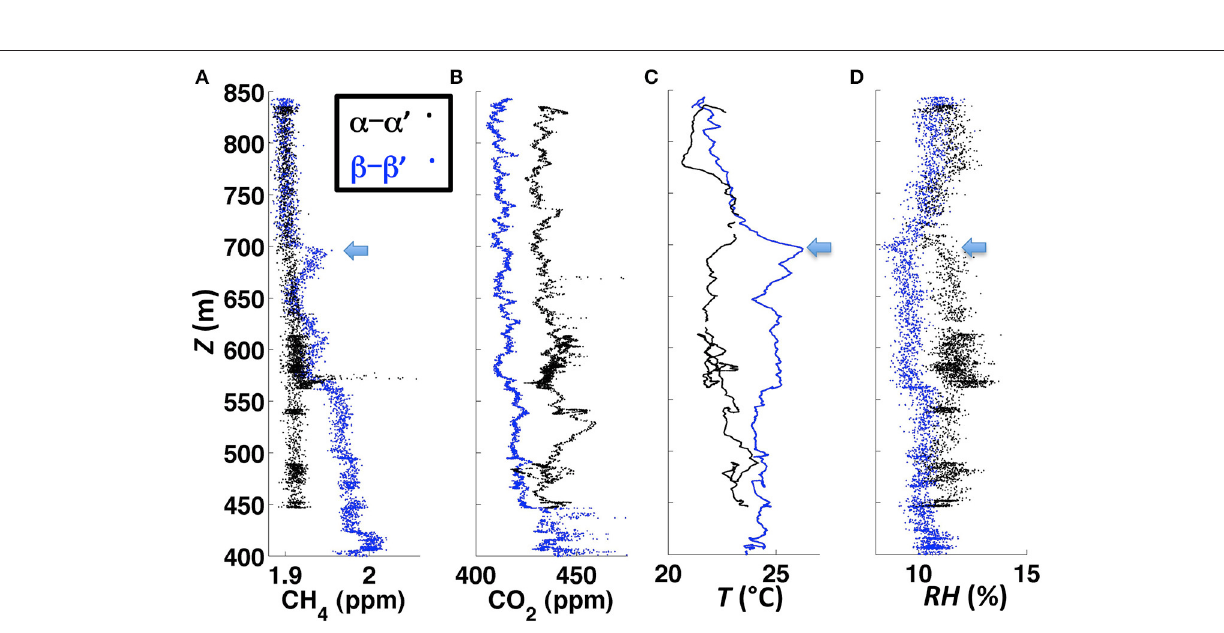
FIGURE 4 | AMOG altitude ( z ) profile data into the San Bernardino Mountains for (A) methane (CH 4 ), (B) carbon dioxide (CO 2 ), (C) temperature ( T ), and (D) relative humidity ( RH ). Blue arrows highlight features showing top of the planetary boundary layer. Vertical profiles ( α – α ′ is ascent profile, β ′ – β is descent profile) are labeled as identified on Figure 3 . Data key on (A)